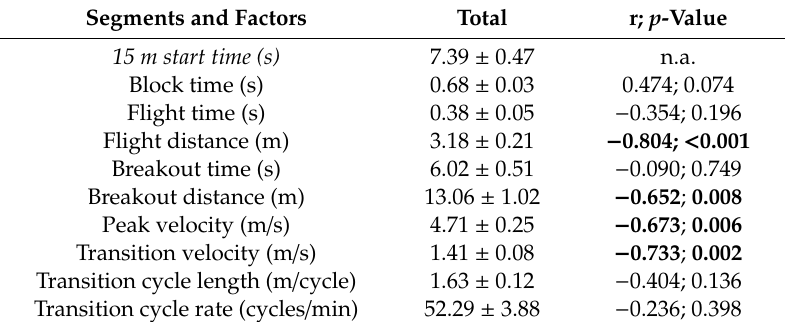
Table 3. Descriptive statistics (mean ± standard deviation) and correlation analysis of the start segment with underlying